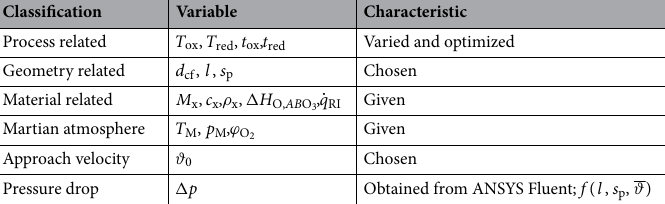
Table 7. Input variables and their